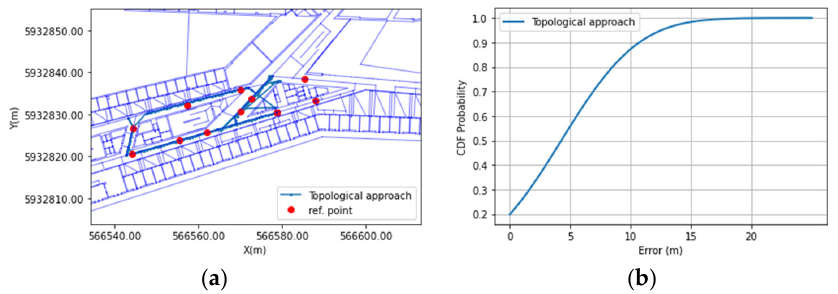
Figure 5. The topological approach: ( a ) The trajectory, including the route graph; and ( b ) Error vs. CDF probability of the mentioned method.